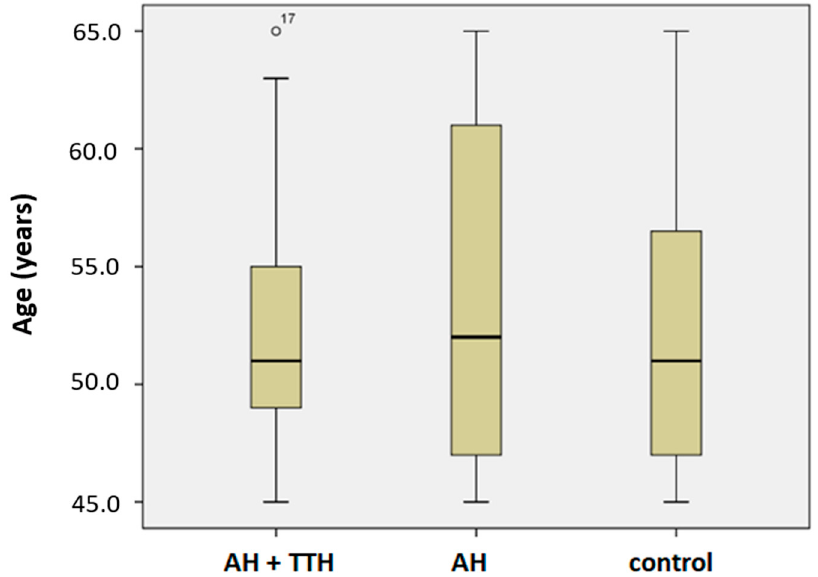
Figure 1. Characteristics of groups by age. Note: AH—arterial hypertension; TTH—tension-type headache.